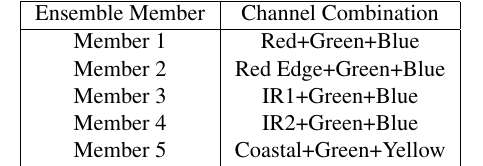
Table 3: Combination of channels as input to ensemble members